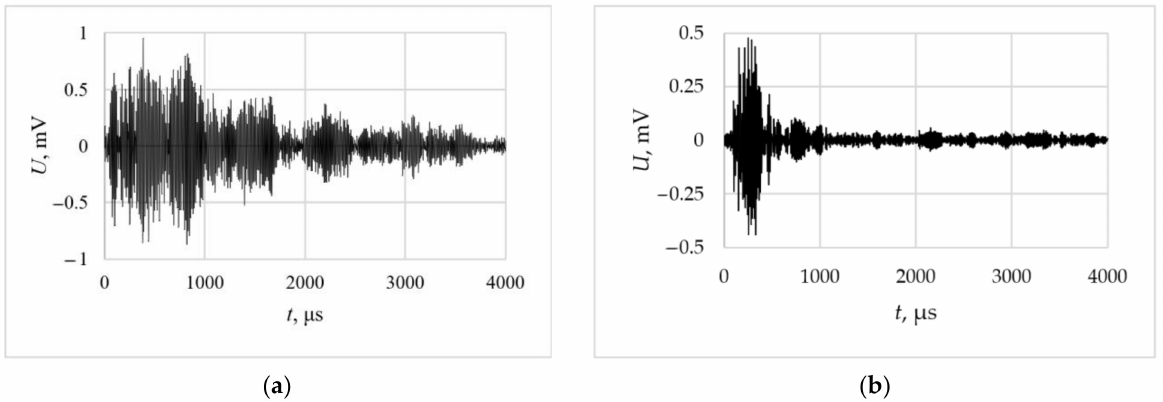
Figure 7. Typical AE signal waveforms for defect-free specimen at σ max = 300 MPa ( a ) and σ max = 400 MPa ( b ).